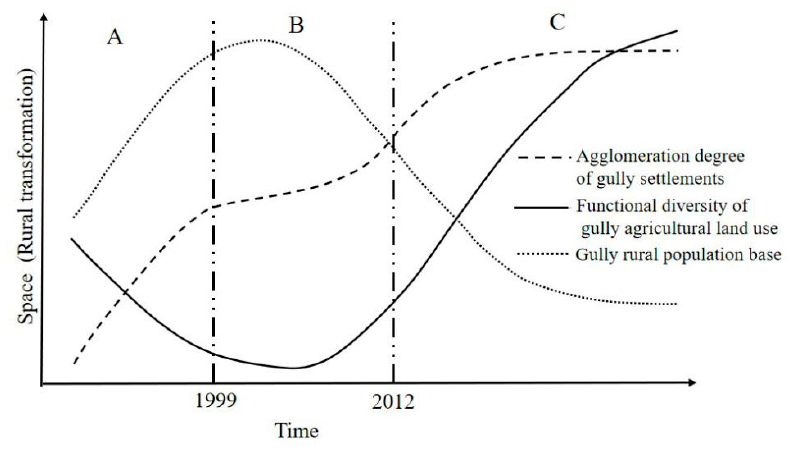
Figure 10. The transformation model of gully rural.